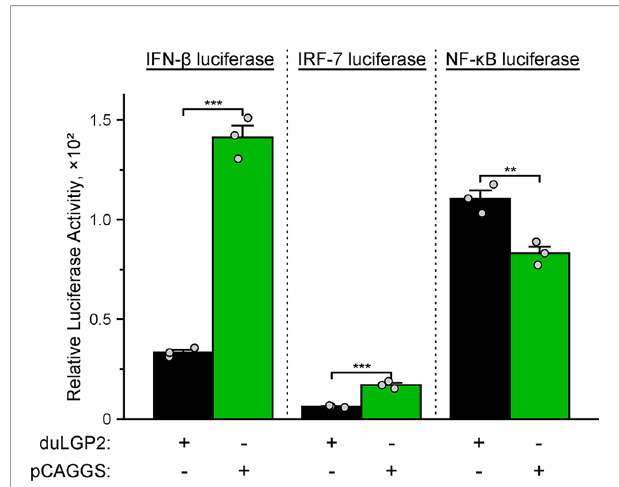
FIGURE 6 | Overexpression of duLGP2 regulates the duRIG-I-mediated IFN- b signaling pathway during DTMUV infection. DEF cells were transiently co-transfected with IFN- b , IRF-7, or NF- k B promoter construct with indicated expression plasmids or empty plasmids pCAGGS. Cells were infected with DTMUV at 24 hpt and lysed at 12 hpi, and luciferase activities were quanti fi ed by normalization with Renilla luciferase activity. All samples were analyzed in triplicate, and all data were expressed as means ± SEM. **Highly signi fi cant difference ( P < 0.01); ***Extremely signi fi cant ( P <